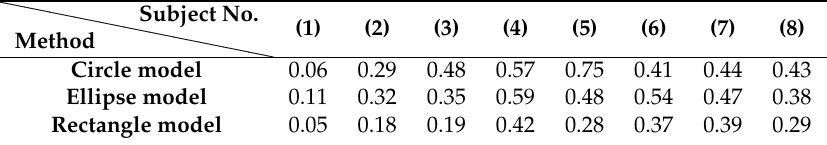
Table 2. Maximum absolute value of AP-diameter estimation